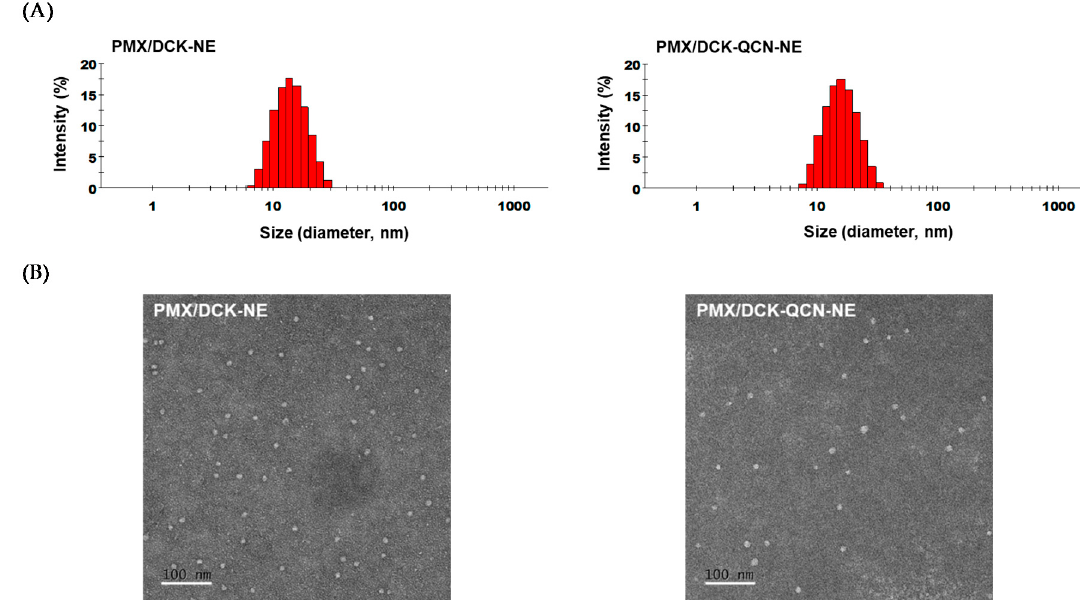
Figure 1. Droplet size distribution ( A ) and transmission electron micrographs ( B ) of pemetrexed/ N α -deoxycholyl- L -lysyl-methylester-loaded nanoemulsion (PMX/DCK-NE) and pemetrexed/ N α -deoxycholyl- L -lysyl-methylester- and quercetin-loaded nanoemulsion (PMX/DCK-QCN-NE). Scale bar represents 100 nm.